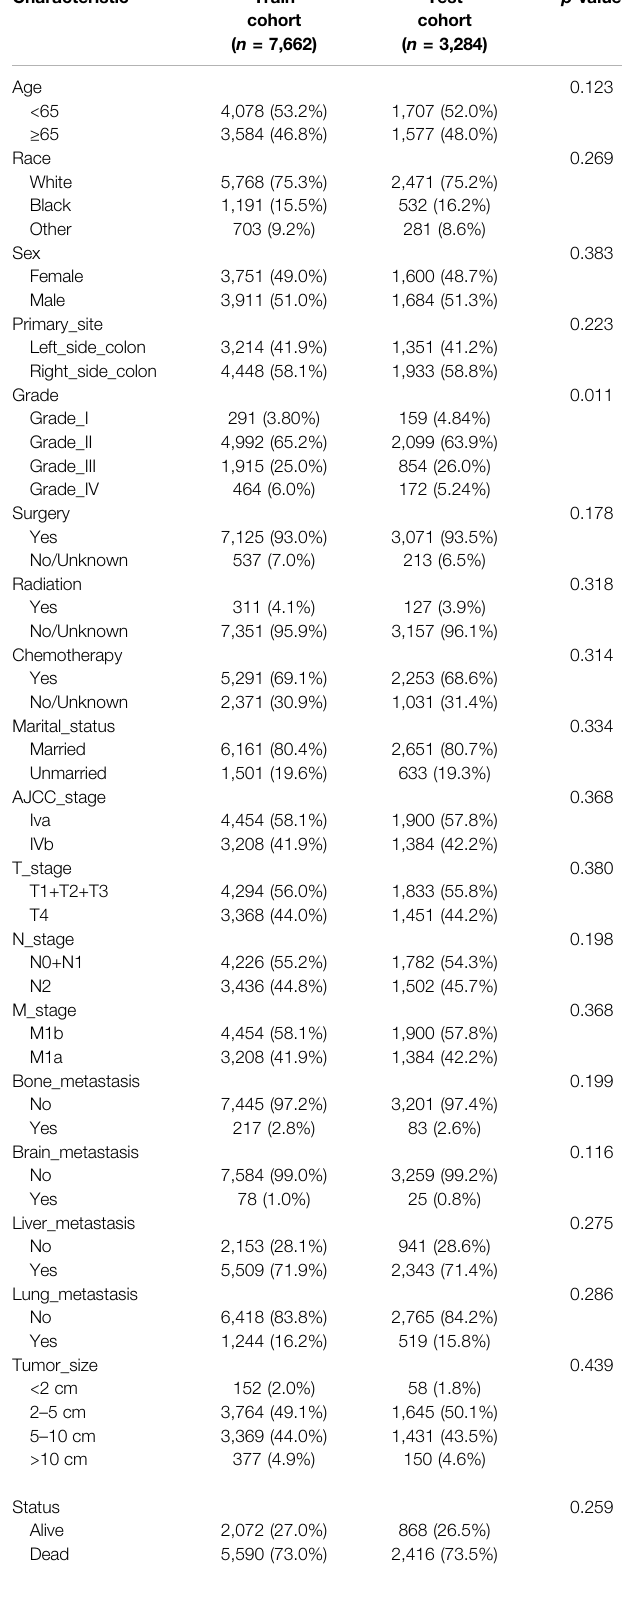
TABLE 1 | Clinicopathological characteristics in mCC